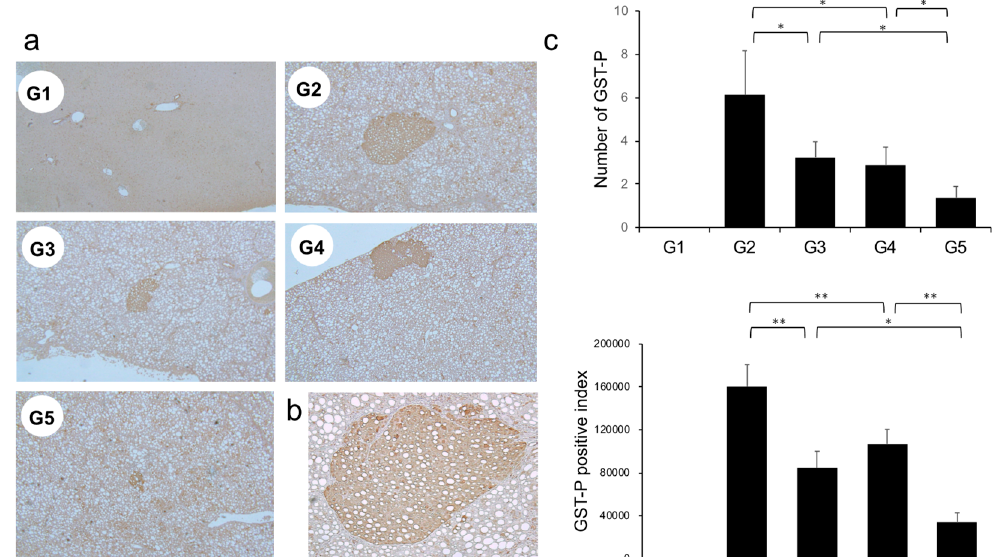
Figure 6. ( A ) Representative photomicrographs of GST-P-positive hepatic preneoplastic lesions. ( B ) Semiquantitative analysis of immunohistochemistry images using ImageJ. ( C ) Higher magnification GST-P-positive hepatic preneoplastic lesions (x100). G1, Group 1 (choline- sufficient, L-amino acid-defined diet); G2, Group 2 (choline-deficient, L-amino acid-defined diet (CDAA)); G3, Group 3 (CDAA + canagliflozin (CA)); G4, Group 4 (CDAA + teneligliptin (TE)); G5, Group 5 (CDAA + CA + TE); Values represent mean ± SD ( n = 10). * p < 0.05, ** p < 0.01.